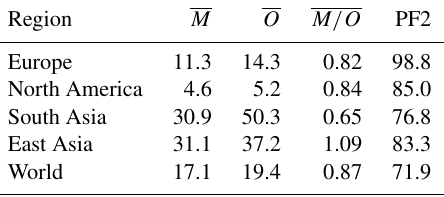
Table 5. Summary for simulated and pseudo-observed annually av- eraged PM 2 . 5 . M and O denote the arithmetic mean of the simu- lated and observed concentrations, respectively (inµgm − 3 ). PF2 is the percentage of simulated points within a factor of 2 with respect to the observations. Region M